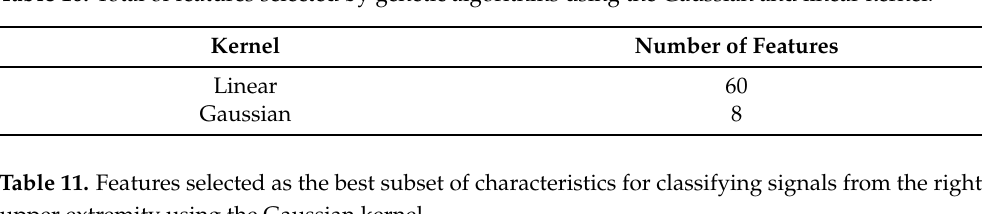
Table 10. Total of features selected by genetic algorithms using the Gaussian and linear kernel.